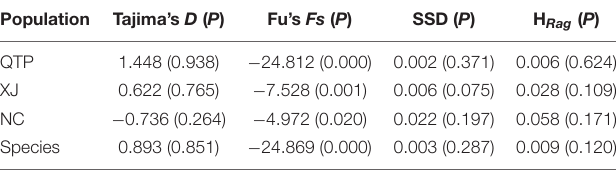
TABLE 8 | Analysis of neutrality and mismatch